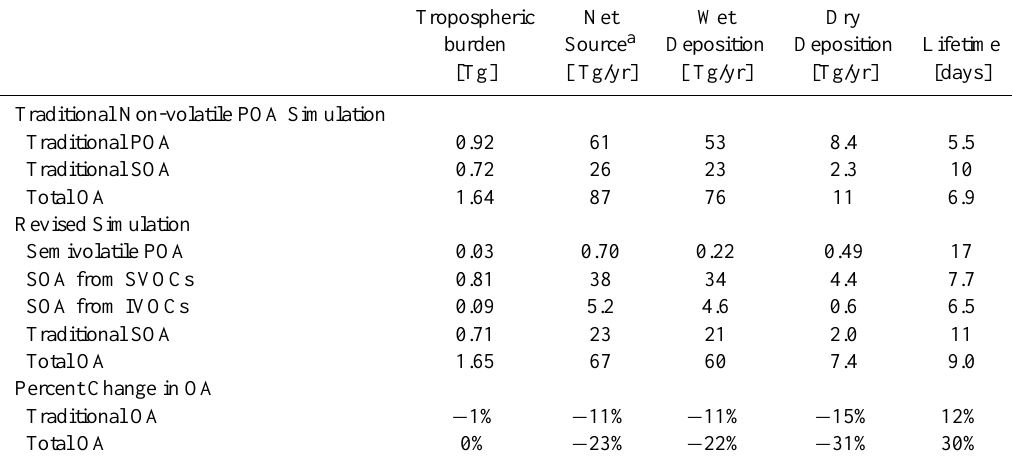
Table 5. Global OA budget for traditional (non-volatile POA) and revised (semivolatile POA, SOA from SVOCs, and SOA from IVOCs) simulations. The OM/OC ratio for traditional, non-volatile POA is 2.1. The OM/OC ratio for semivolatile POA is 1.4. The OM/OC ratio for all SOA is 2.1. Simulations were performed at 2 ◦ × 2 . 5 ◦ horizontal resolution with GEOS-4 meteorology. Tropospheric Net Wet Dry burden Source a Deposition Deposition